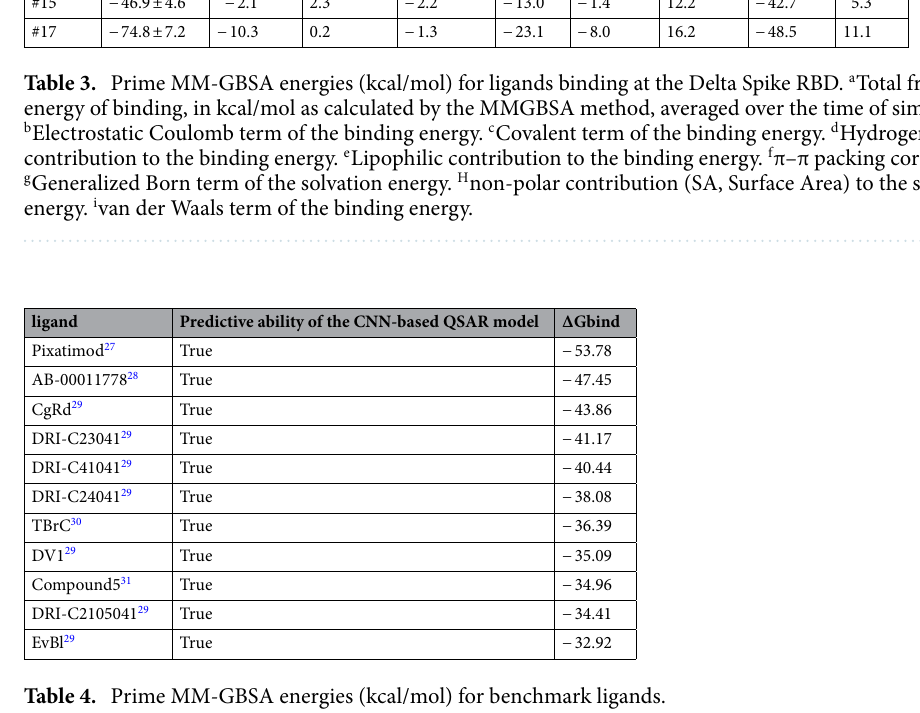
Table 4. Prime MM-GBSA energies (kcal/mol) for benchmark ligands.